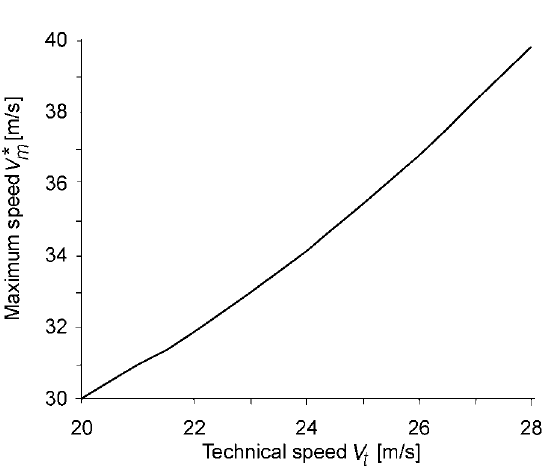
ν depending on Fig 2 . Variations of traction vehicle optimal power h P m depending on technical speed within segment 15 = k s km for s km k train-car mass 600 = w m